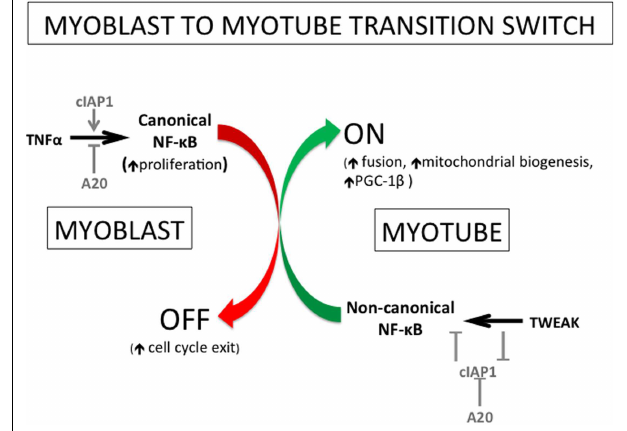
FIGURE 4 | Roles ofTNF α ,TWEAK, cIAP1/2, andA20, in myogenesis in the regulation of switching from canonical to non-canonical NF- κ B signaling .The transition from myoblast to myotube has been known for several years to involve a switch from canonical to non-canonical NF- κ B signaling. More recently, several of the key players and the mechanisms of action for this switch have been identified.The promotion ofTNF α -mediated canonical NF- κ B signaling involves the positive regulation by the E3 ubiquitin ligase cIAP1/2 and the negative regulation by the deubiquitinase A20.The non-canonical pathway is oppositely controlled: it is negatively regulated by cIAP1/2 and positively regulated by A20. Interestingly, the cytokineTWEAK (a pathological factor in muscle atrophy) has been recently shown to stimulate non-canonical NF- κ B signaling by removing the negative regulation of cIAP1/2 on that NF- κ B pathway. Physiological levels ofTWEAK, in fact, promote myogenesis through the enhancement of myoblast fusion amongst other things.The non-canonical NF- κ B pathway has been shown previously to regulate mitochondrial biogenesis and to promote myotube maintenance, and recently shown to do so through the NF- κ B-mediated induction of the mitochondrial regulator PPAR- γ co-activator 1 β (PGC-1 β ). Figure adapted from Ref.